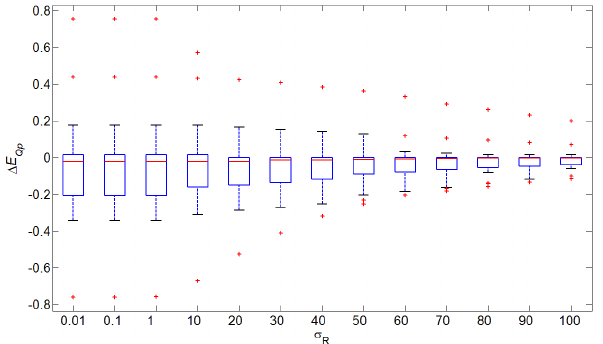
Fig. 5. Value of the 1E Q p criterion for the 20 flood peaks tested for various observation error standard deviations σ R . Red crosses correspond to extreme values, red lines represent the median, horizontal blue lines represent the lower and upper quartiles and black lines represent the lower and upper deciles.